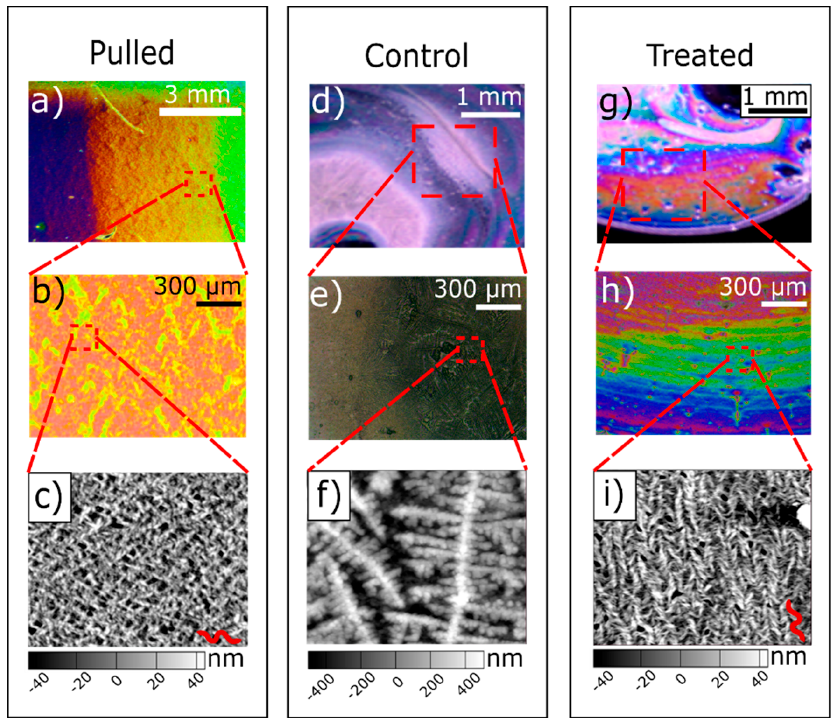
Figure 3. Optical and atomic force microscope images of reference, control, and experimental samples. ( a ) Reference sample fabricated by the pulling method. ( b ) Magnified section from the pulled sample, showing a film of SHN bacteriophage reflecting a single color. ( c ) Atomic form microscope (AFM) image of sample exhibiting SHN structures fabricated by the puling method. An SHN is traced in red to help identify the structure. ( d ) Control sample of a bacteriophage dispersion drop-cast with no applied electric field. ( e ) Magnified section from control sample, exhibiting no color change. ( f ) AFM image of untreated control sample exhibiting agglomerated bacteriophages. ( g ) Electric field-treated sample using a 6 mg / mL M13 bacteriophage dispersion treated with 10 V pp at 15 kHz during evaporation. ( h ) Magnified section of the electric field-treated sample, exhibiting a color change due to the SHN structure but with shorter and less uniform color bands compared to 3b. ( i ) AFM image of the electric field-treated sample showing aligned bundles of bacteriophages in SHN structure. A tracing of one of the SHNs is shown in red to help identify the bacteriophage bundle structure.